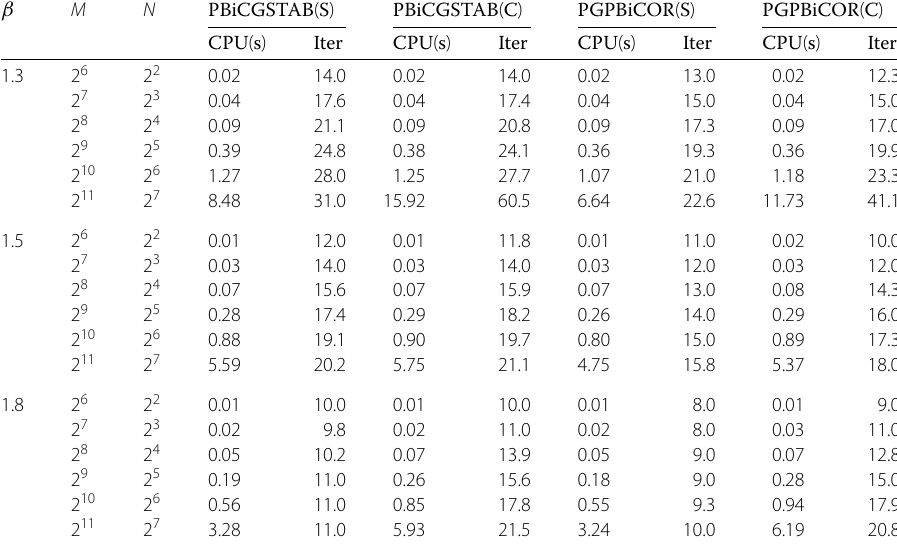
Table 4 Comparisons for solving Example 5.1 by the PBiCGSTAB/PGPBiCOR(2, 1) method with two circulant preconditioners, where β = 1.3,1.5,1.8, α = 0.5, q = 10, and T = 0.75